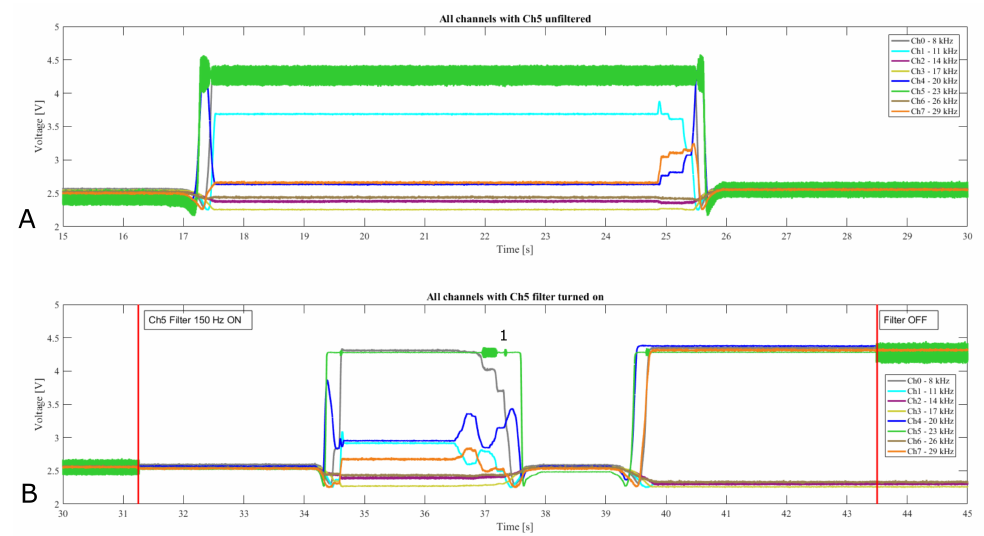
Figure 10. Figure shows a data acquisition from all 8 channels from 15 to 45 s split in two plots ( A , B ). ( A ) Post-filter on channel 5 is OFF. ( B ) Between seconds 31 and 32 the filter was switched ON and then OFF between seconds 43 and 44. This shows how the noise induced from channel interaction could be removed to clean Channel 5 which is affected.